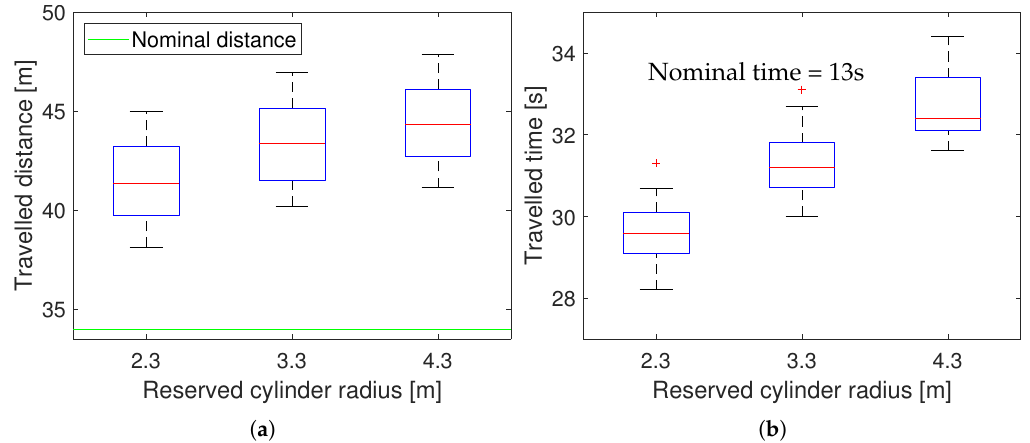
Figure 7. 3D-SWAP results in simulations increasing reserved radius. ( a ) Traveled distance. ( b ) Traveled time.